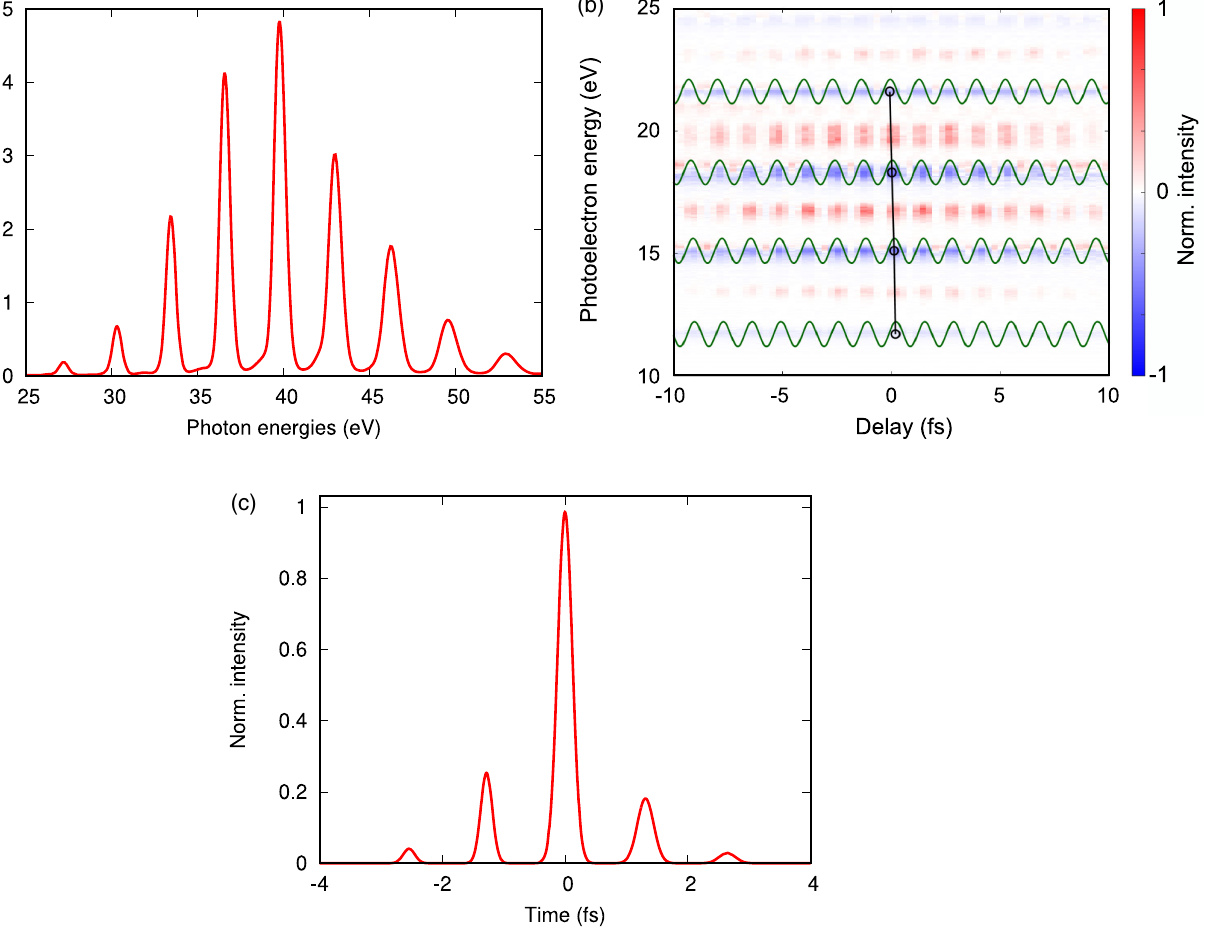
FIG. 5. (a) XUV spectrum. (b) Differential RABBITT spectrogram. The photoelectron spectrum is recorded as a function of pump- probe delay, where positive delays mean that the infrared pulse arrives before the XUV pulse. (c) Reconstructed XUV